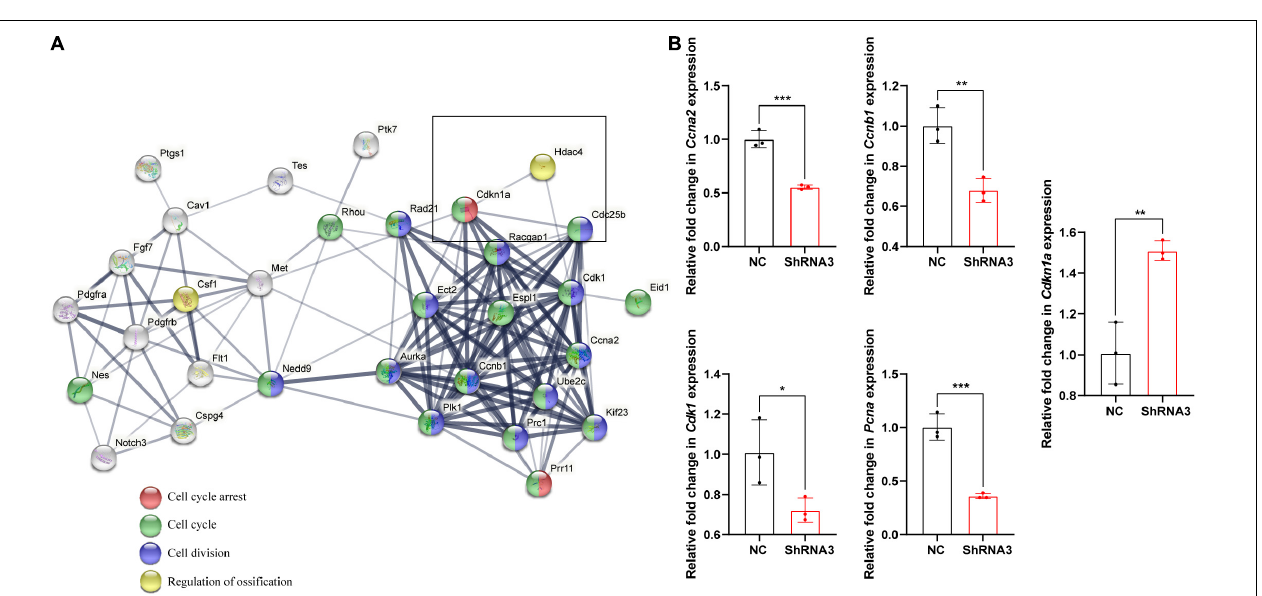
FIGURE 5 | (A) The STRING database (https://string-db.org/) was used to analyze the protein–protein interaction network relating to the cell cycle-related genes present among the top 500 differentially expressed genes and their interaction with Hdac4. Protein interactions between HDAC4 and CDKN1A as determined